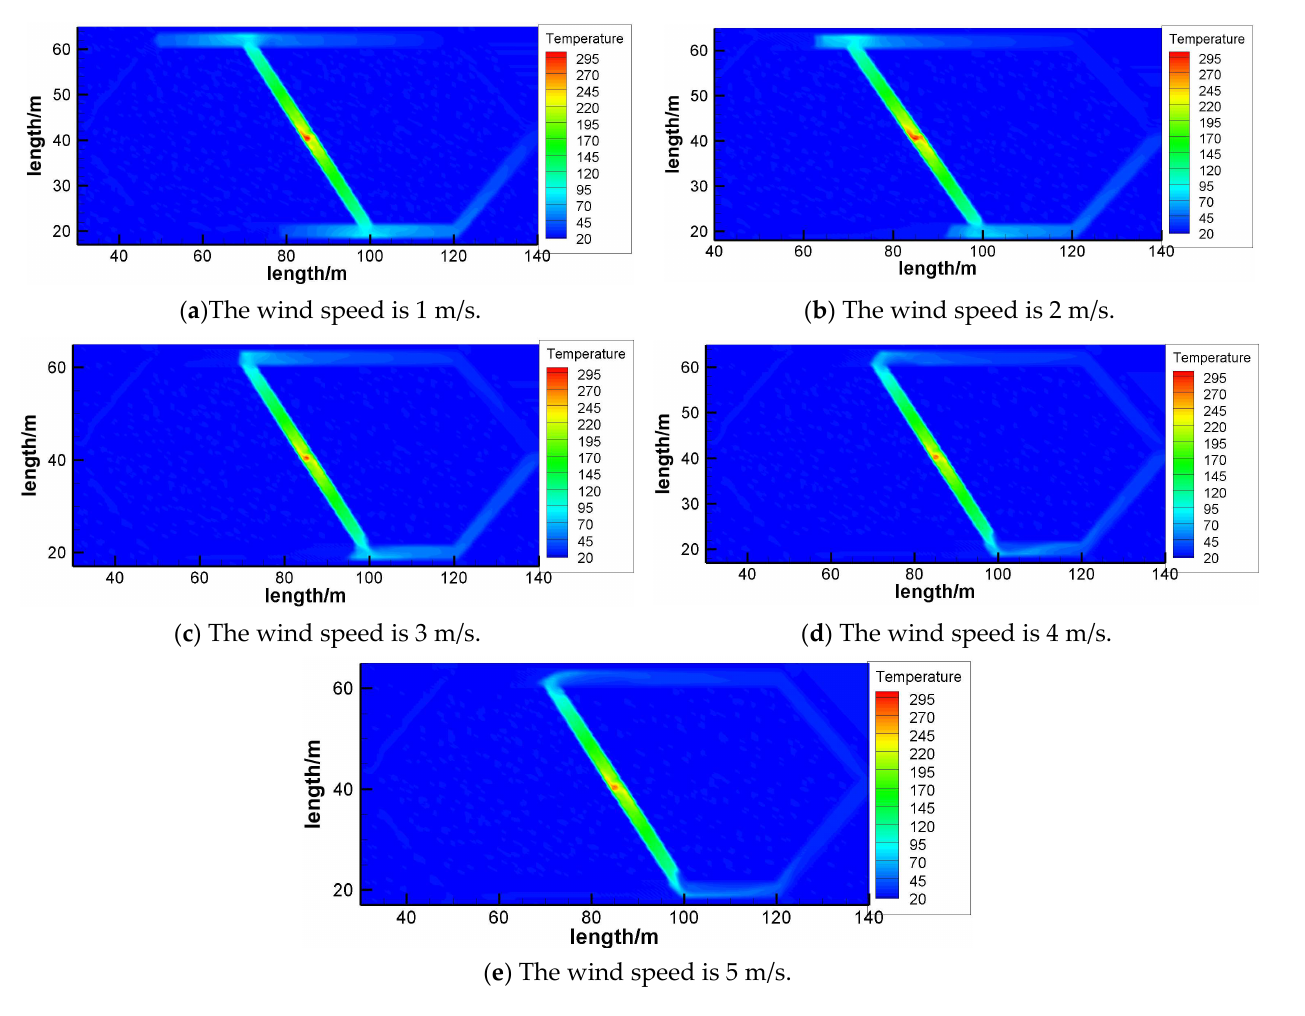
Figure 8. The temperature distribution of the diagonal pipe network under different wind speeds.